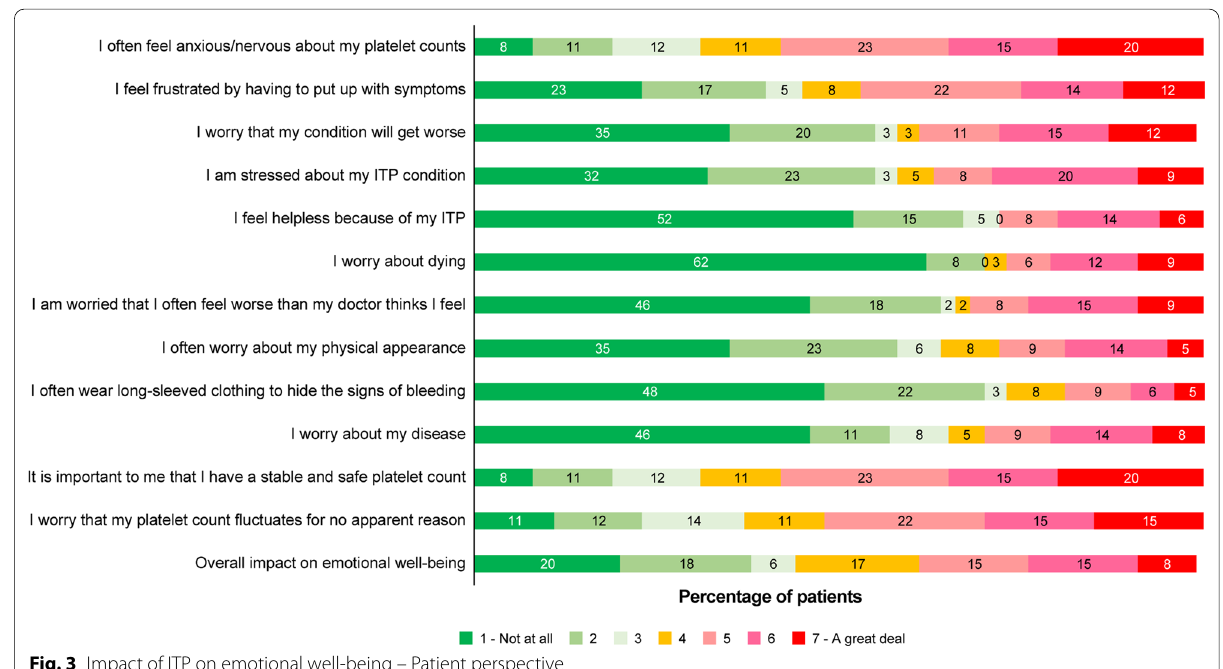
Fig. 3 Impact of ITP on emotional well-being – Patient perspective